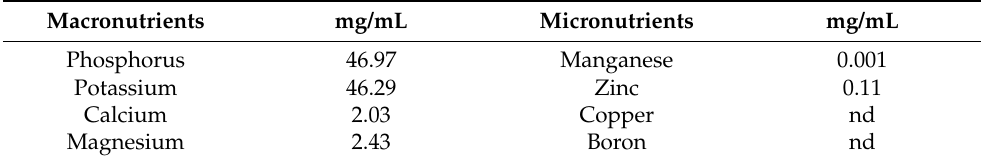
Table 2. Nutrient composition (mg/mL) of the black soldier fly ( Hermetia illucens ) larvae frass tea. Macronutrients